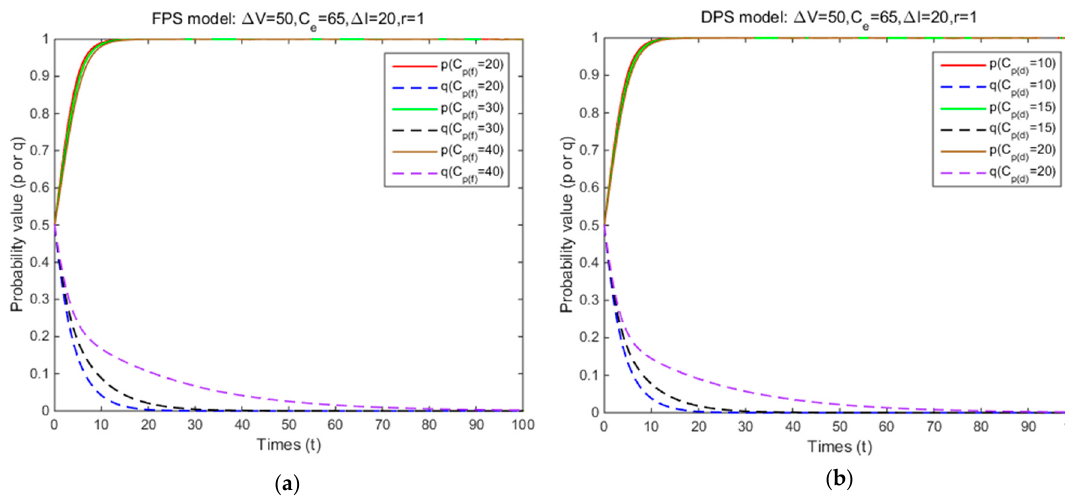
Figure A2. The e ff ects of penalty amount on strategy probabilities of cyclists and law enforcement under FPS ( a ) and DPS ( b ) (Situation